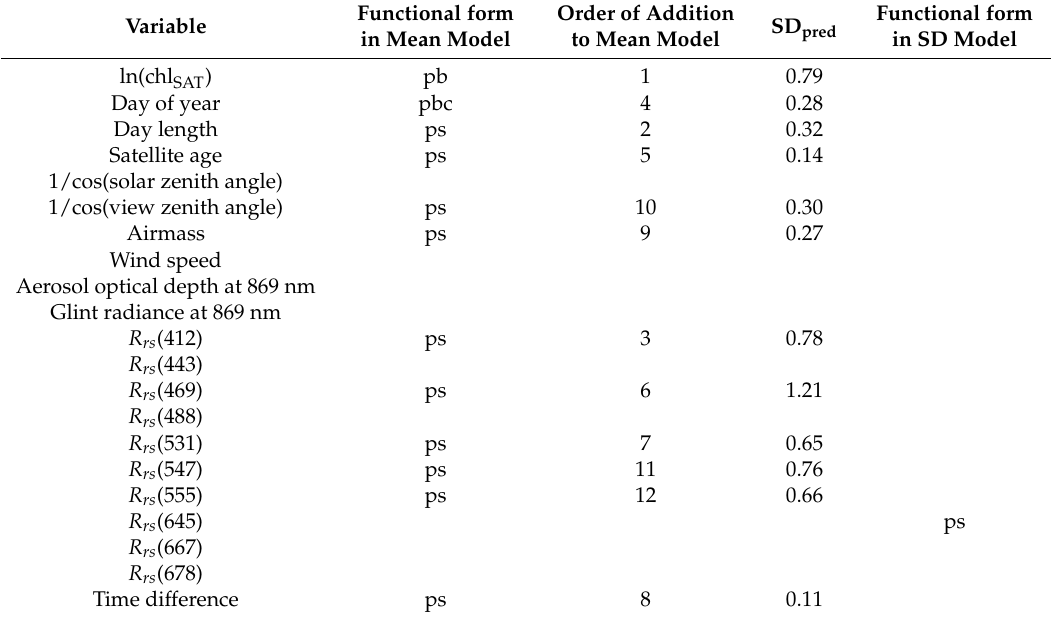
SD models, order of addition (1 = first) and SD PRED . Variables with blank lines were not chosen by gamlssCV.